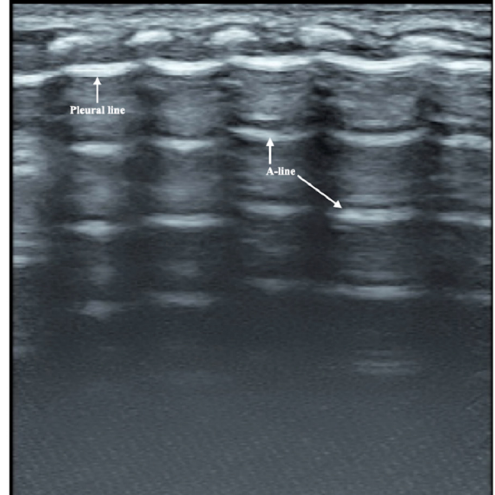
Figure 3. Normal lung ultrasound manifestations. On B-mode ultrasound, the pleural line and A-line show smooth, regular and hyperechoic lines arranged in parallel and equidistant from each other. Together, they form a kind of bamboo-like performance, which is known as the bamboo